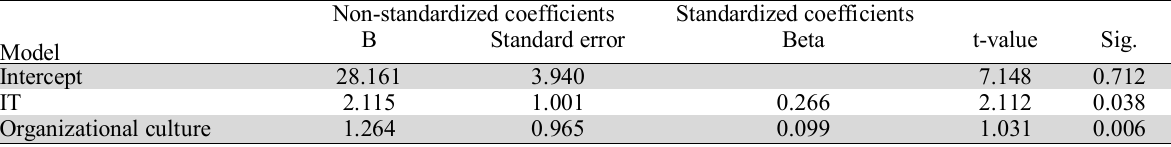
The summary of regression analysis between organizational strategy (dependent variable) and IT and organizational